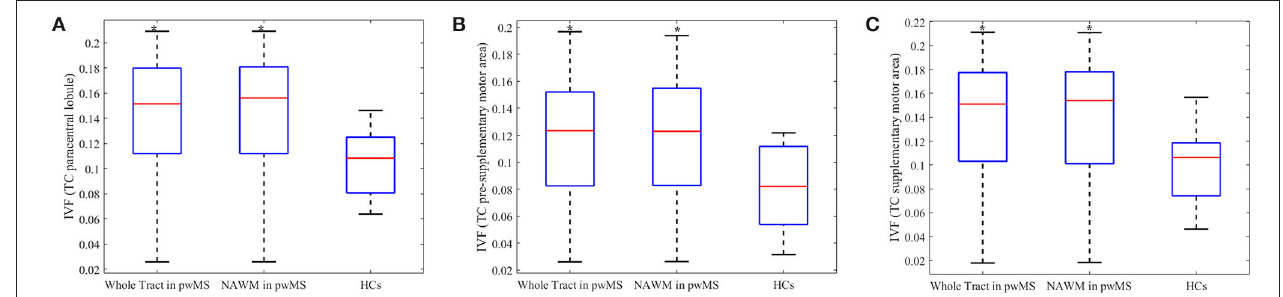
FIGURE 3 | Boxplots of metrics which were significantly different between person with multiple sclerosis and healthy controls. The isotropic volume fraction (IVF) values of the transcallosal (TC) paracentral lobule (A) , TC pre-supplementary area (B) and TC supplementary motor area tracts (C) . The IVF values of whole tract and normal appearing white matter (NAWM) in person with multiple sclerosis (pwMS) and whole tract of healthy controls (HCs) are presented. The upper and lower black horizontal bars represent maximum and minimum values, respectively. The upper and lower blue horizontal bars represent the upper and lower quartiles, while the red bar represents the median of the group. Asterisks indicate the metrics found to be statistically different ( p ≤ 0.05) in pwMS compared to HCs.